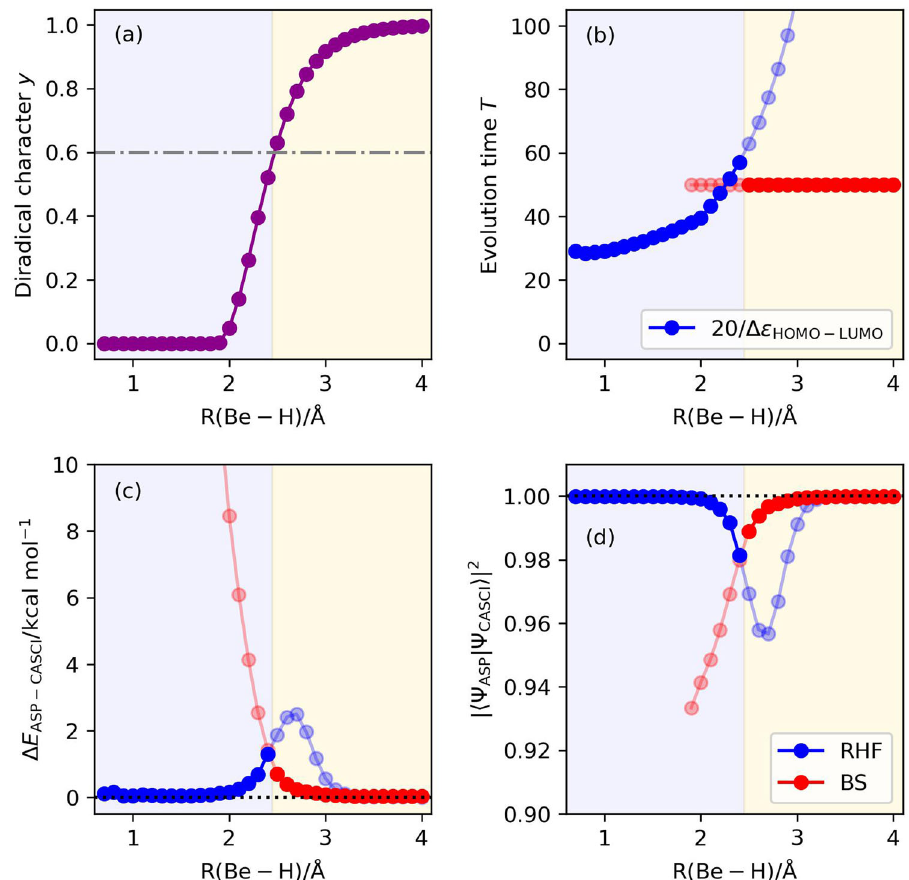
Fig. 9 Results of the numerical simulation of ASP of the potential energy curve of the symmetric bond dissociation in BeH 2 molecule, using the diradical character as the indicator for selecting the initial wave function selection. Background colors specify the regions of the initial wave function recommended from the criterion based on the diradical character y > 0.6. Sinusoidal and square functions were adopted as the scheduling functions with the | Ψ HF 〉 and | Ψ BS 〉 , respectively, as the starting wave function. a Diradical characters calculated using Eq. 6. b Evolution time lengths. c The energy differences from the CASCI values. d The square overlaps with the CASCI wave functions.